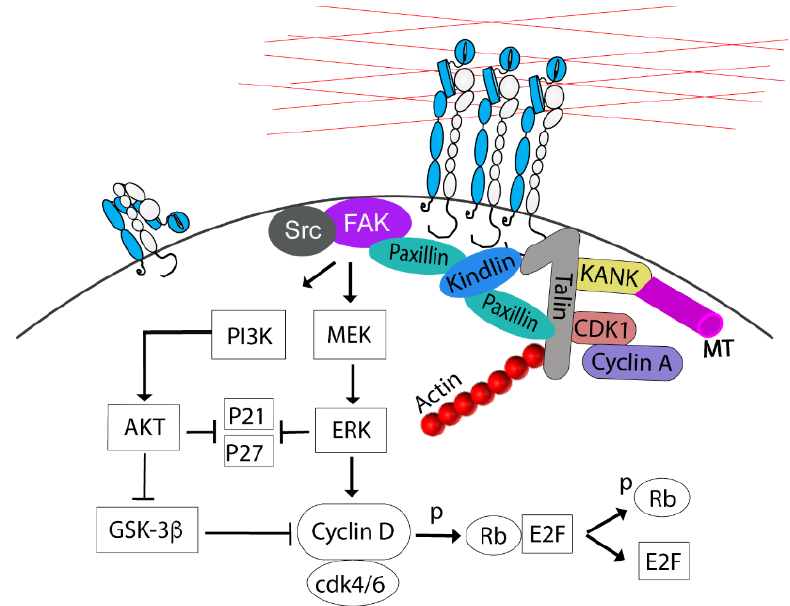
Figure 1. A schematic picture showing some of the main components of CAs, the interaction of cell cycle kinase CDK1 with talin, and the central adhesion-dependent events regulating the G1 to S transition. Paxillin both links kindlin to the GTP-Rap1-activated talin and recruits FAK to the complex. Integrin α -units are shown in blue and the β -units are in white. The red lines represent the extracellular matrix.